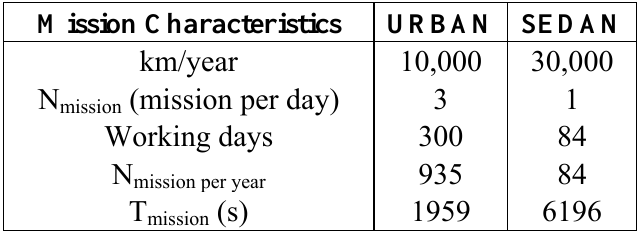
Table 10. Assumptions used for economic